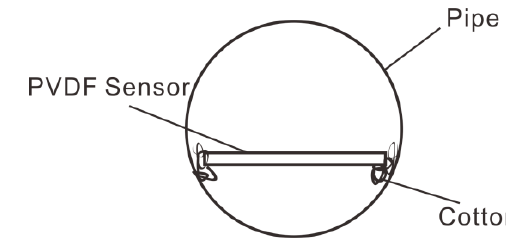
Figure 12. Cross section of pipe.